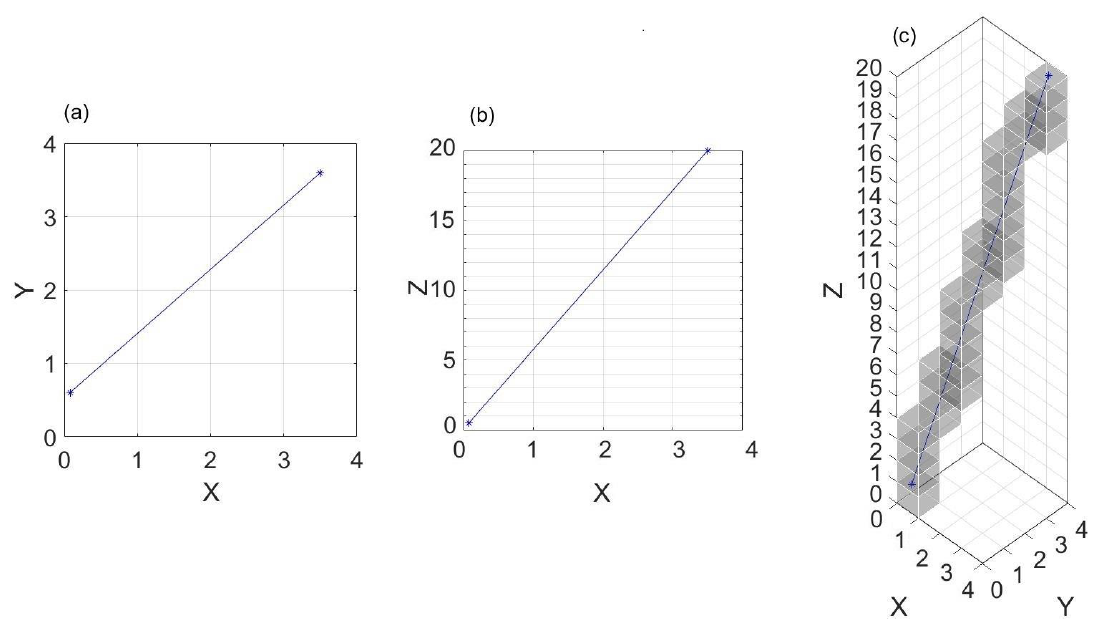
Figure 5. Demonstration of the fast voxel traversal algorithm for ray tracing through the model grid ( a ) XY plane projection; ( b ) XZ plane projection; ( c ) a 3D display of rays passing through the model.